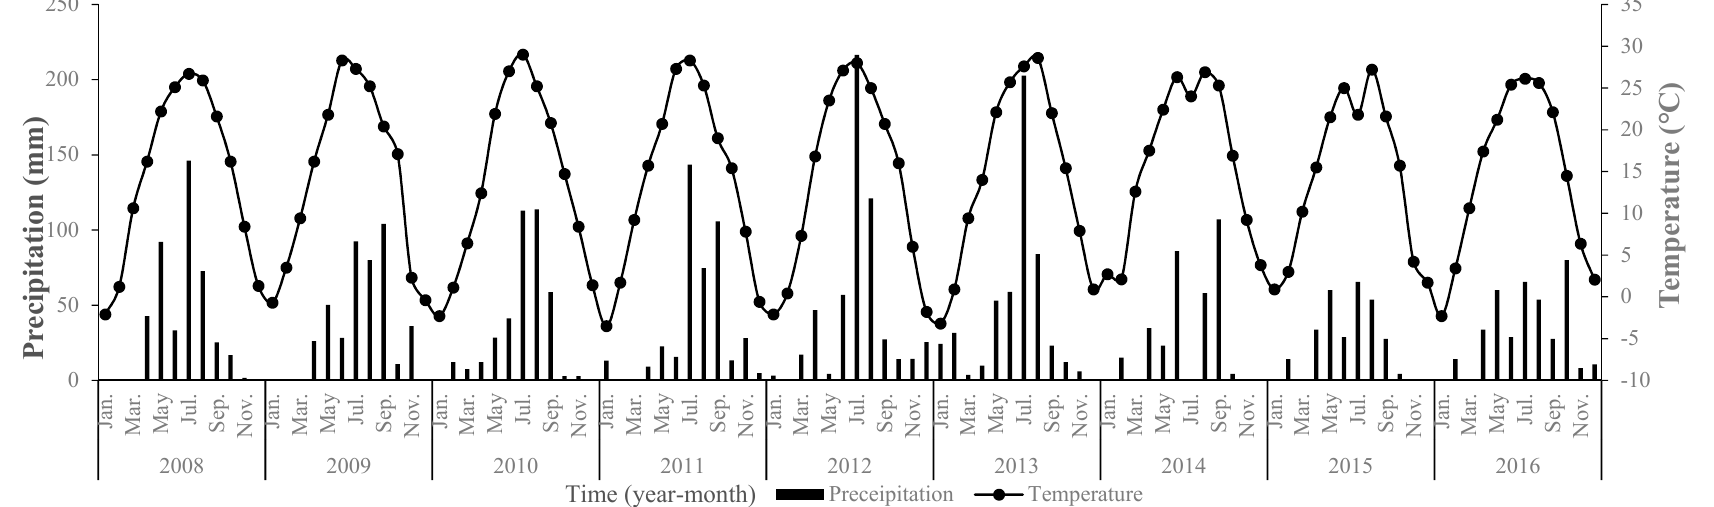
Figure 1. Monthly air temperature (°C) and precipitation (mm) at the experimental site in North China Plain region, China. Table 1. Soil properties of the 0–20 cm top layer before the start of the experiment (2007). Soil Layer